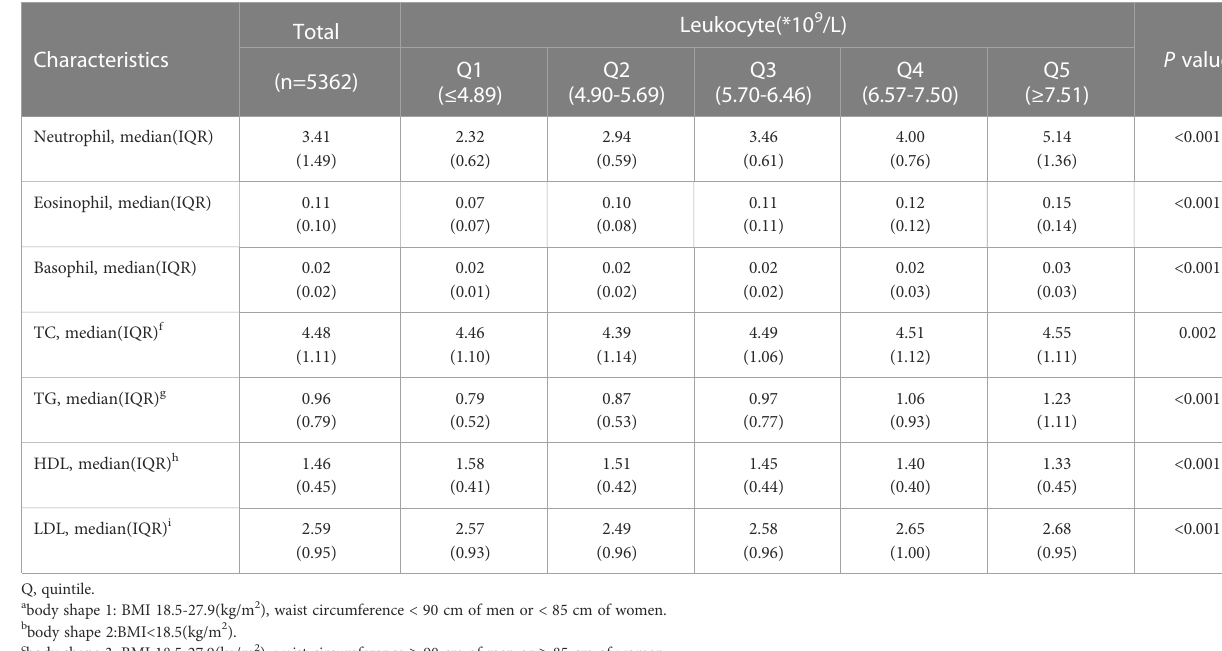
After adjusting for other covariates, the relationship between neutrophils and T2D was signi fi cant in model 3 and model 4. People with a neutrophil count of Q5 had more than four times the HR for T2D compared to those with Q1. The results of the time-